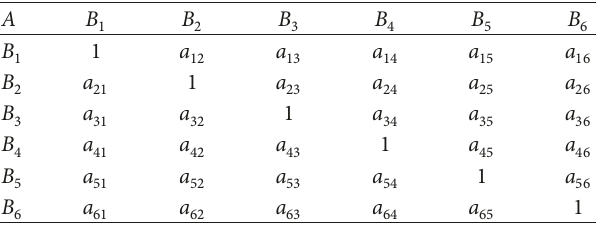
Table 6: The discriminant